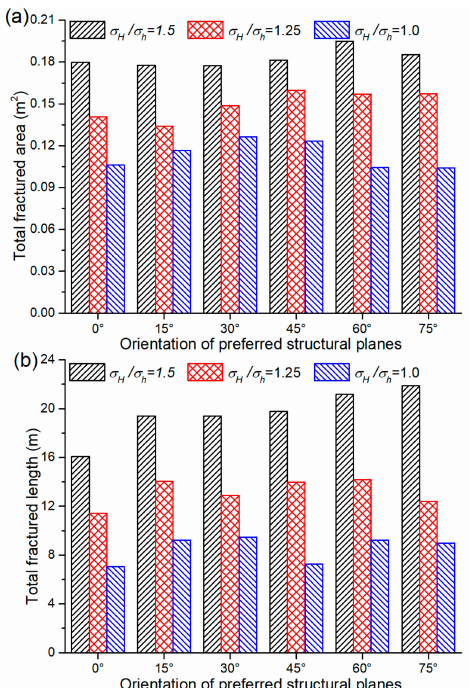
Figure 9. Total fractured area ( a ) and total length of fractures ( b ) for di ff erent in-situ stress ratios. The injection rate was the same as for the base